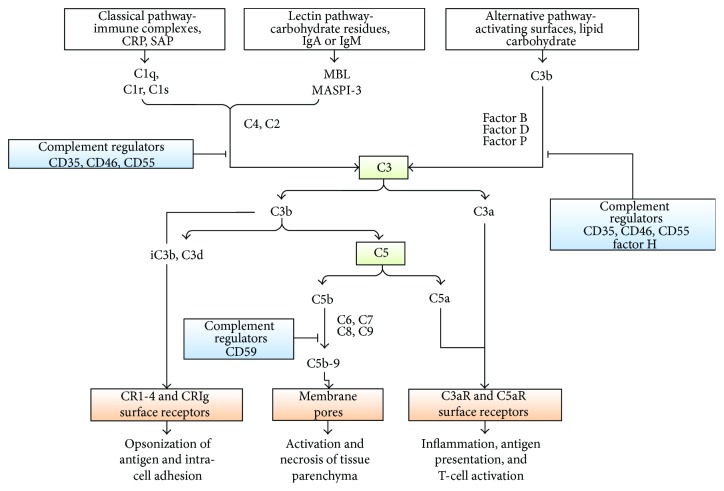
The complement cascades (adopted from [84]).